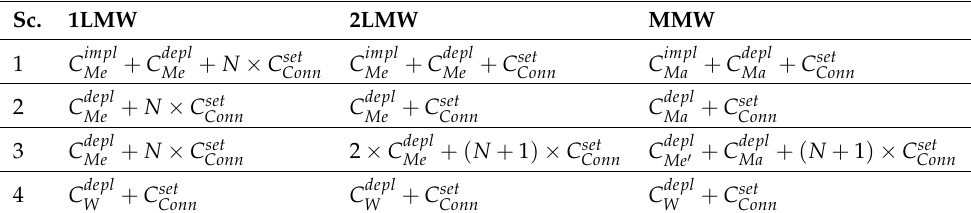
Table 2. Shift costs for all scenarios and